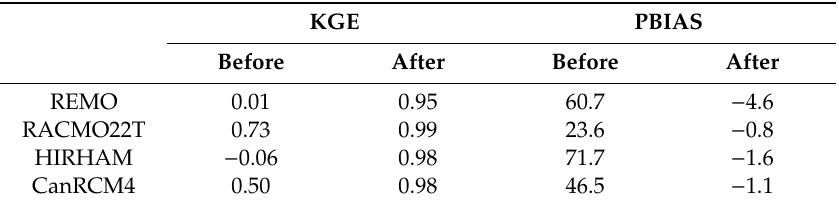
Table 5. Bias correction efficiency at seasonal scale.